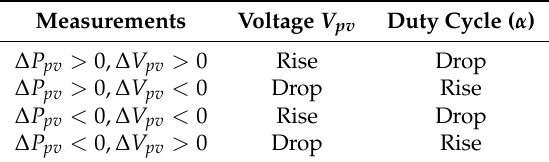
Table 2. Behavior of P&O